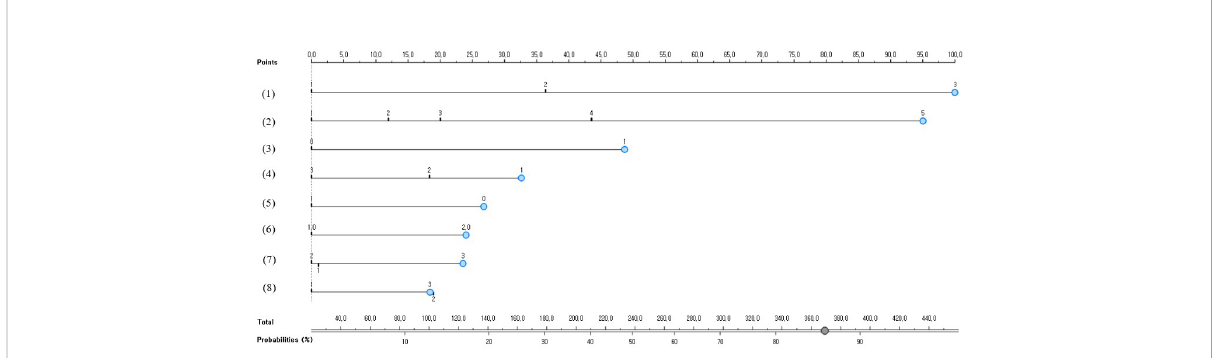
FIGURE 2 A nomogram for predicting impaired fasting glucose predictors in South Korean non-diabetics; (1) Age (1 = 30-39 years old, 2 = 40-49 years old, or 3 = 50-64 years old); (2) BMI (1 = underweight, 2 = normal weight, 3 = pre-obesity class, 4 = class 1 obesity, or 5 = class 2 obesity or higher); (3) High cholesterol (0 = no or 1 = yes); (4) Marital status (1 = living with a spouse, 2 = separated/divorced/bereaved, or 3 = single); (5) Drinking more than one shot per month for the past year (0 = no or 1 = yes); (6) WHtR (1 = <0.5 or 2 = 0.5 ≤ ); (7) Smoking (1 = non-smoker, 2 =